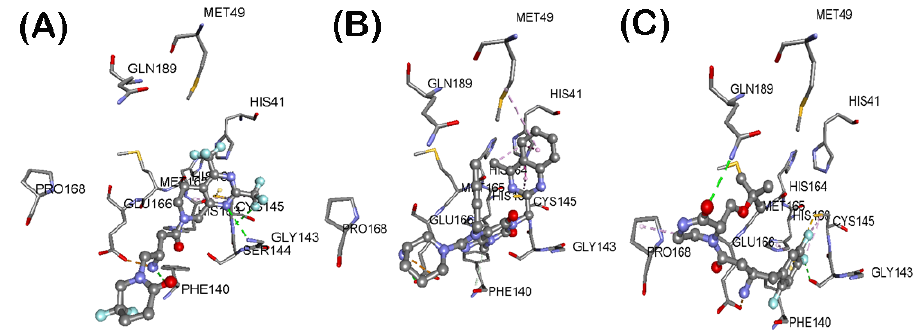
Figure 3. Binding modes of DPP4 inhibitors gemigliptin ( A ), linagliptin ( B ) and evogliptin ( C ) (stick cartoon) in the SARS-CoV-2 M pro protomer (PDB ID: 6Y2F). Hydrogen atoms are not shown to enhance clarity.